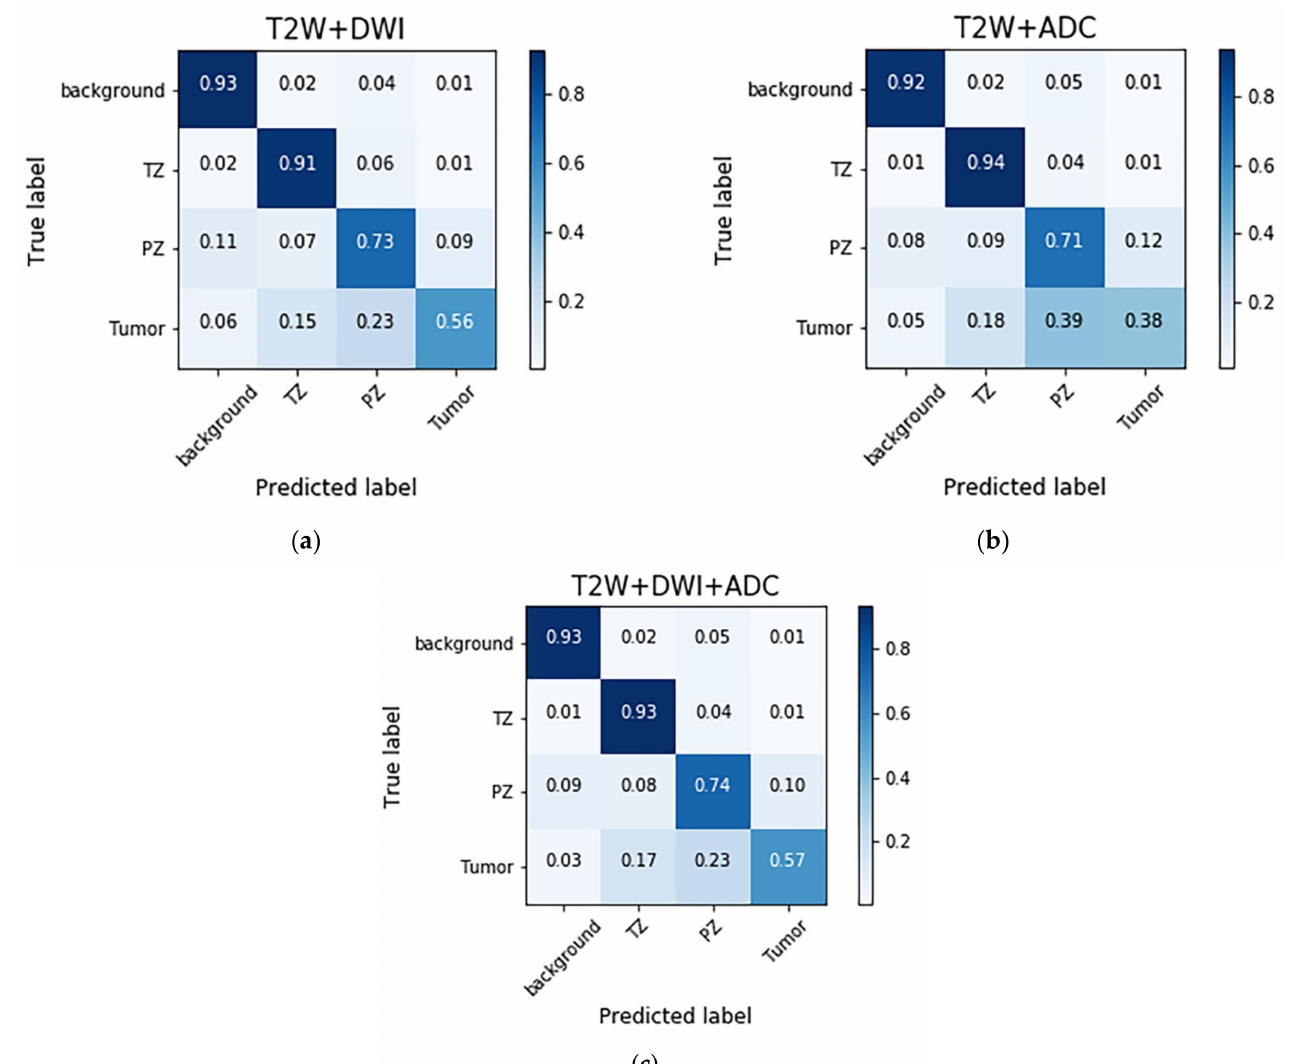
Figure 3. Normalized confusion matrices for the prediction results obtained with different image combinations. The results are presented in percentages. The total number of pixels was 5,570,560 (256 × 256 × 85). ( a ) T2W image + DWI model,